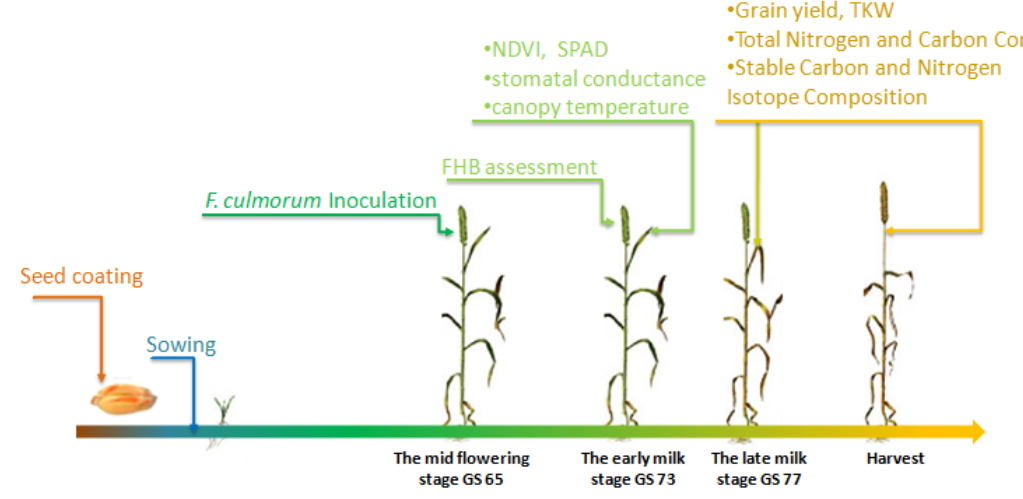
Figure 1. Illustration of the timeline of the field experiment; six manipulative steps are shown along the experiment timeline: (1) seed coating with 3 treatments ( M. guilliermondii ; the combination M. guilliermondii-T. harzianum ; “Panoramix”) plus the non-inoculated and inoculated controls (each on 3 replicated pots) at one hour before sowing; (2) sowing; (3) aerial inoculation of wheat spikes with F. culmorum at the mid-flowering growth stage. (4) At 20 days post-inoculation (at the early milk stage), destructive sampling for disease assessment (100 heads per plot) and non-destructive measurements at the flag leaf level (NDVI, SPAD, stomatal conductance, canopy temperature); (5) collection of flag leaf samples for N/C content and isotopic compositions. (6) At harvest, quantification of grain yield, TKW, and grain sampling for N/C content and isotopic compositions. See methods for further details.